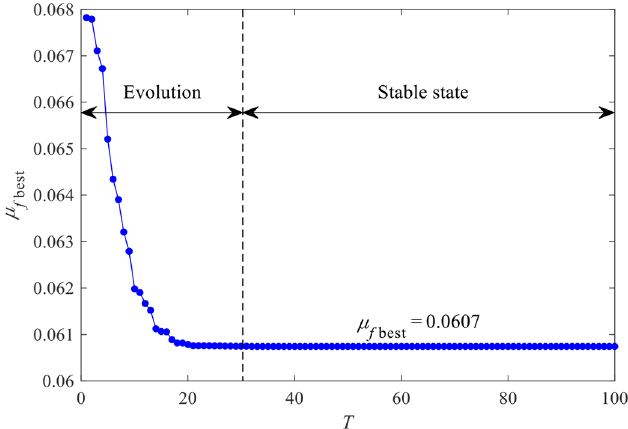
Fig. 5. The m f best varying with the generations under e =0.1, ’ = 0.